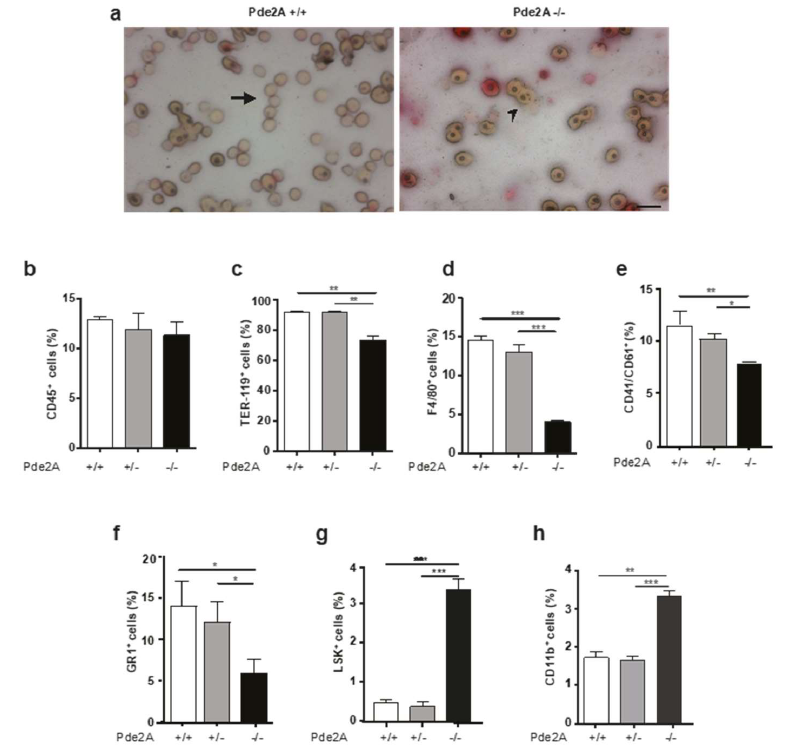
Figure 5. Impairment of blood cells maturation in PDE2A − / − embryos. ( a ) Smear of blood from E14.5 PDE2A +/+ and PDE2A − / − embryos. Arrowhead indicates nucleated red blood cells originated in the yolk sac; arrow indicates mature non-nucleated cells derived from liver. Scale bars: 20 µ m. In PDE2A − / − embryos the immature nucleated blood cells are predominant compared to PDE2A +/+ . ( b – h ) Flow cytometry analysis of liver cells isolated from E14.5 PDE2A +/+ , PDE2A +/ − , PDE2A − / − embryos, stained with antibodies against CD45, Ter119, F4 / 80, CD41 / CD61, GR1 and LSK markers. Ter119, F4 / 80, CD41 / CD61, GR1, that label mature erythrocytes, macrophages, megakaryoblasts and granulocytes respectively, show statistically significant reduction, whereas LSK and CD11b, detecting stem / progenitor cells, show a significant increase in PDE2A − / − samples compared to PDE2A +/+ and PDE2A +/ − embryos. N = 4 embryos / genotype. * P < 0.05; ** P < 0.01; *** P <